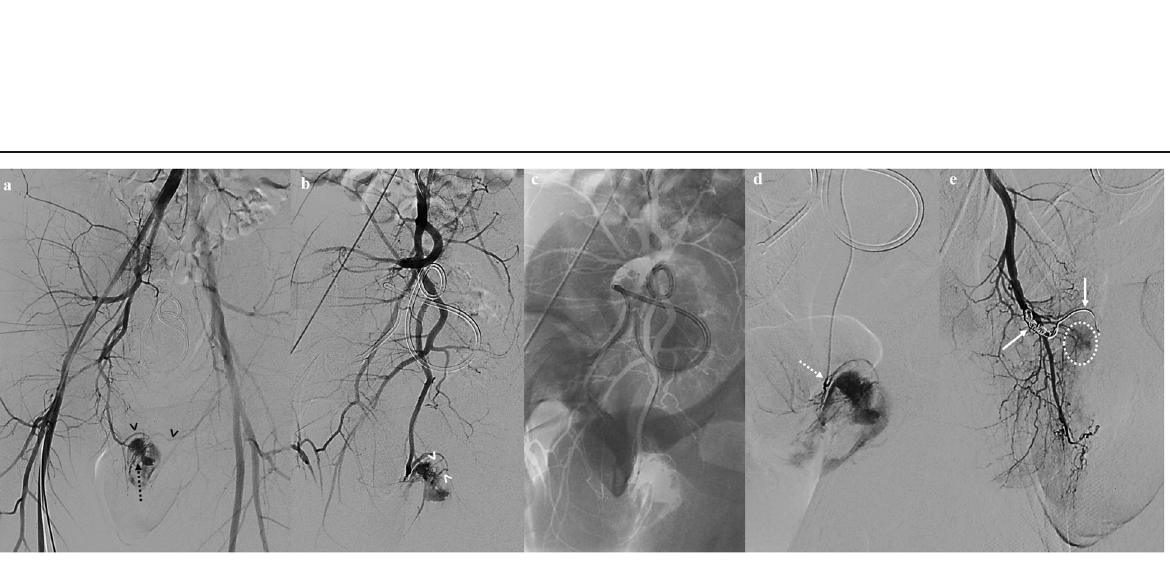
Fig. 3 Angiography, first procedural time: diagnostic angiography and endovascular embolization of right pudendal branches ( a ) digital subtraction angiography (DSA) with pig-tail catheter in abdominal aorta showing arterial active blush at penis root (discontinued black arrow) bilaterally supplied (heads of black arrows); ( b ) DSA of right hypogastric artery showing.urethral-bulb arterial branches (heads of white arrow), distal branches of the internal pudendal artery and localization of the vascular injury; ( c ) Ultra-selective microcatheterism of the target vessel under road-map guidance; ( d ) DSA showing contrast agent extravasation into the urethral bulb performed with microcatheter ’ s tip at the origin ostium of the urethral-bulb arterial branch (discontinued white arrow); ( e ) DSA of the internal pudendal artery after endovascular embolization with micro-coils (white arrows), the vascular injury is successfully excluded and the physiological «cavernosal blush» (discontinued white oval) is